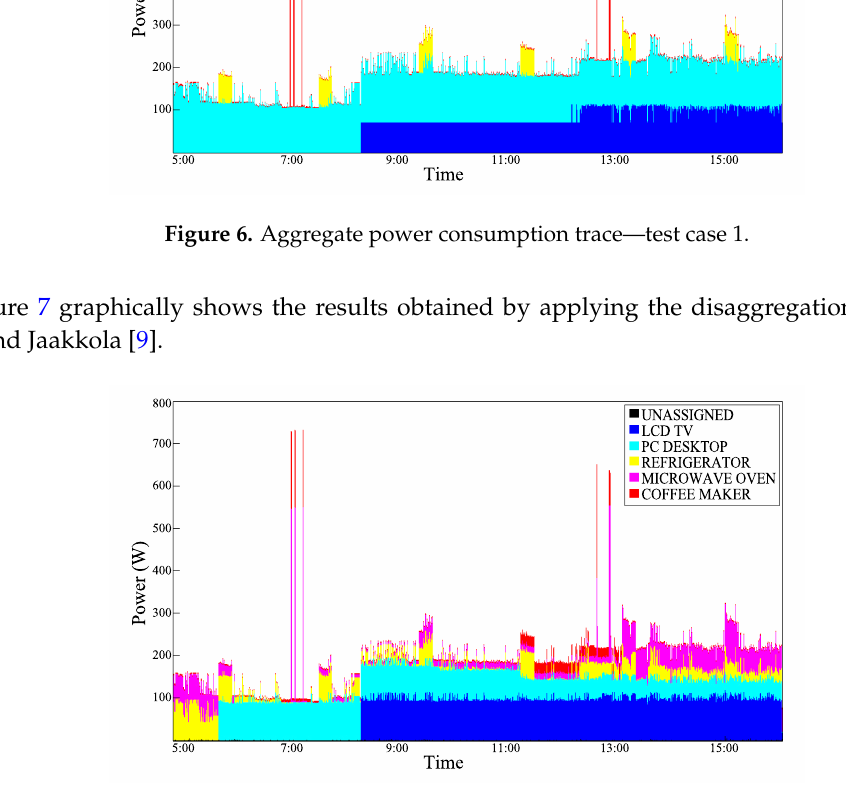
Figure 7. Power consumption trace disaggregated with the basic Kolter and Jaakkola [9]’s Additive Factorial Approximate MAP (AFAMAP) algorithm - test case